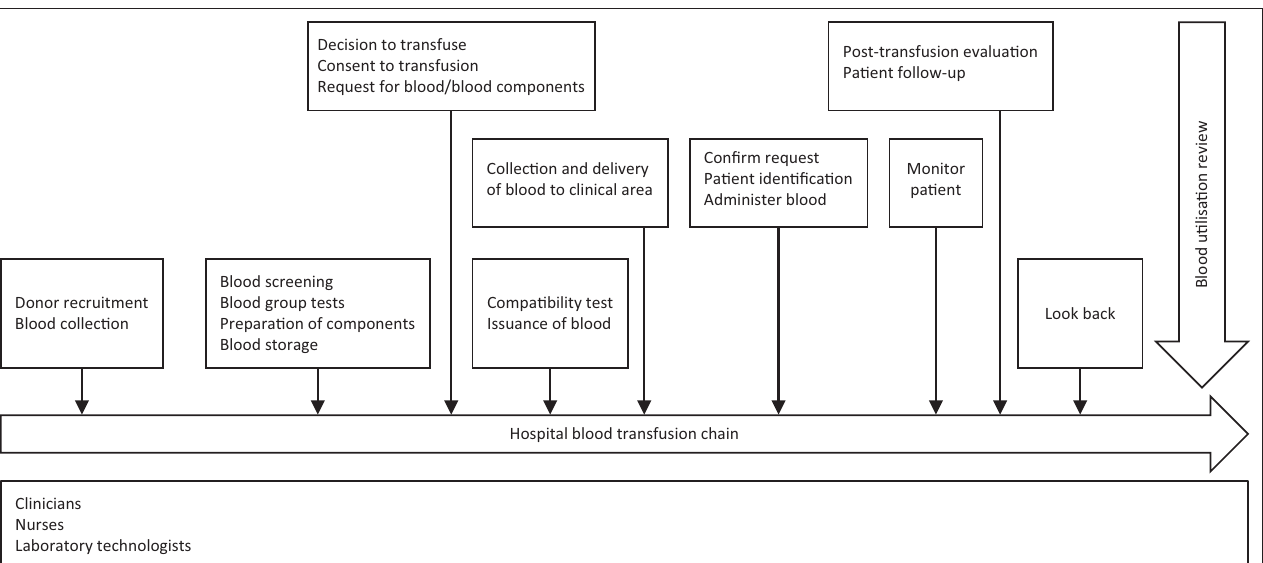
FIGURE 1: Blood transfusion